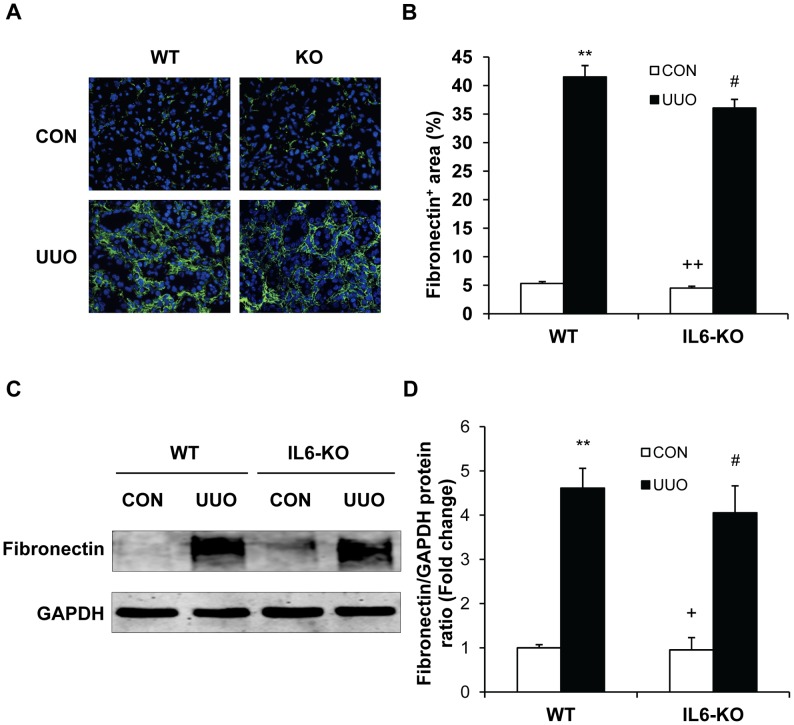
Effect of IL-6 deficiency on fibronectin expression in the kidney.
A. Representative photomicrographs of fibronectin immunostaining in the kidney of WT and IL-6 KO mice after UUO (original magnification X400). B. Quantitative analysis of interstitial fibronectin protein expression in the kidney sections of WT and IL-6 KO mice. ** P<0.01 vs WT control, #
P>0.05 vs WT UUO, and ++
P<0.01 vs KO UUO. n = 5 per group. C. Representative Western blots show the protein levels of fibronectin in the kidney of WT and IL-6 KO mice. D. Quantitative analysis of fibronectin protein expression in the kidney of WT and IL-6 KO mice. ** P<0.01 vs WT controls, #
P>0.05 vs WT UUO, and +
P<0.05 vs KO UUO. n = 4 per group.